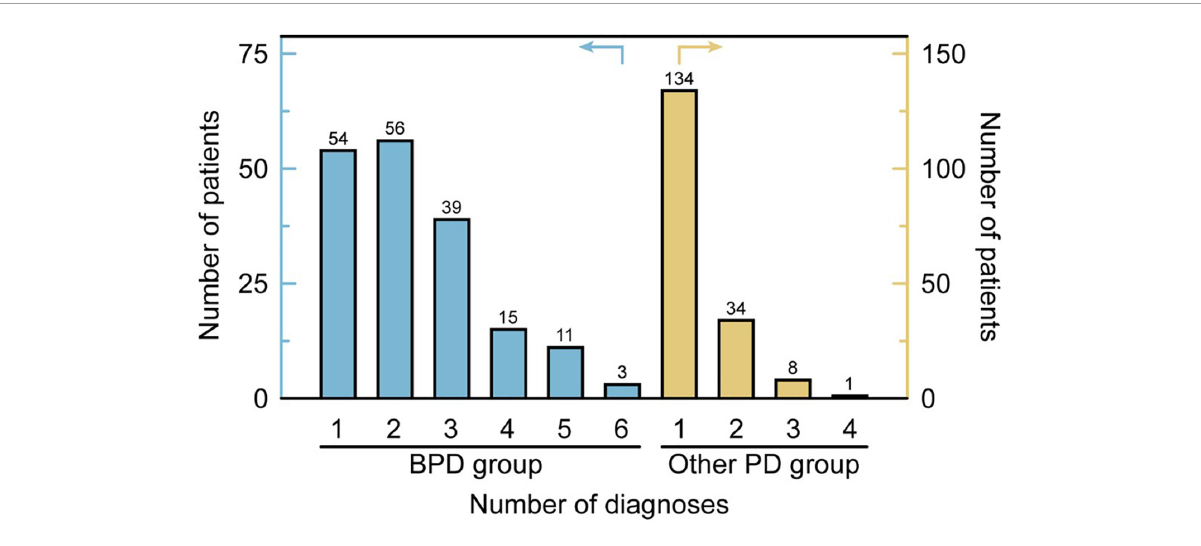
FIGURE2 The number of comorbidities of PDs in the BPD group and other PD